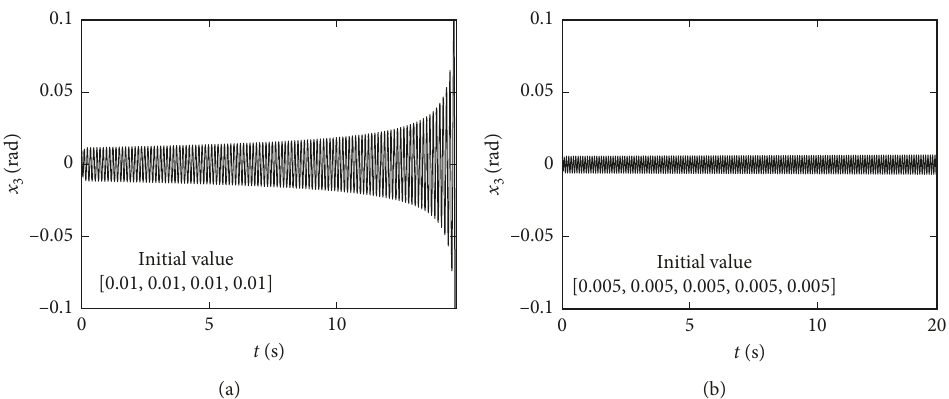
Figure 9: Comparison of amplitudes at different initial values of the controlled system: C